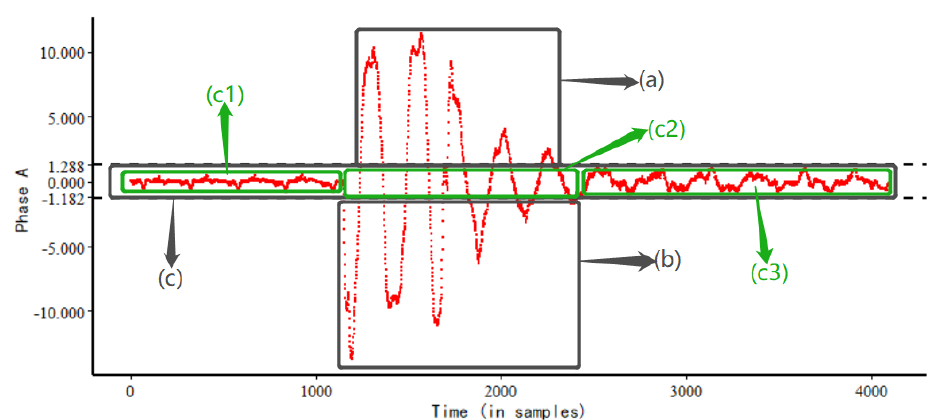
Figure 6. Region segmentation of the filter sequence (id